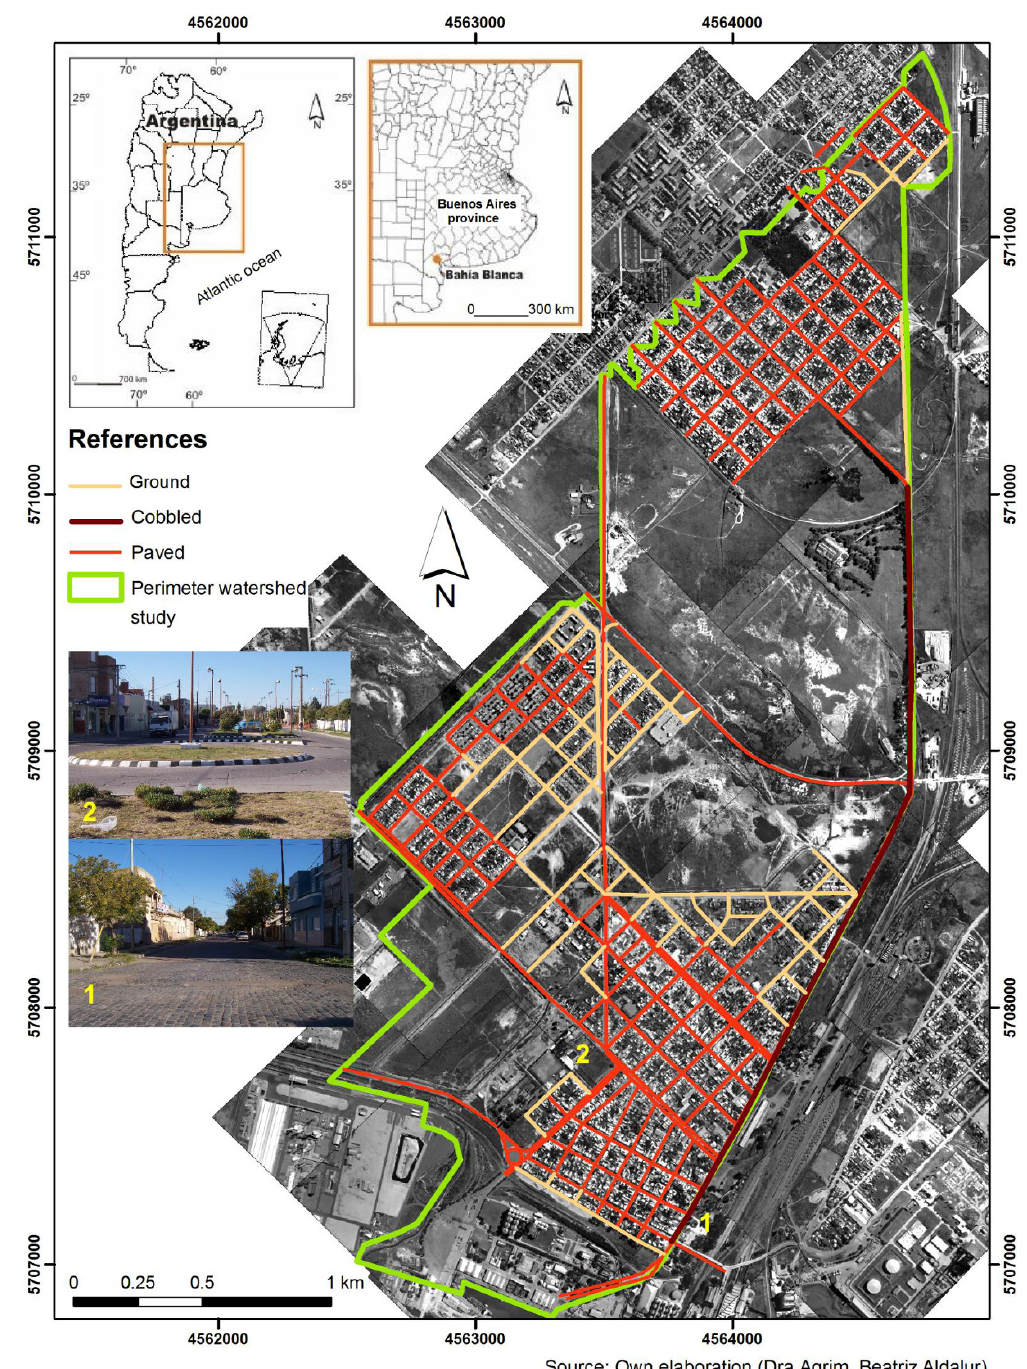
Figure 5. Mapping of paved, ground and cobbled